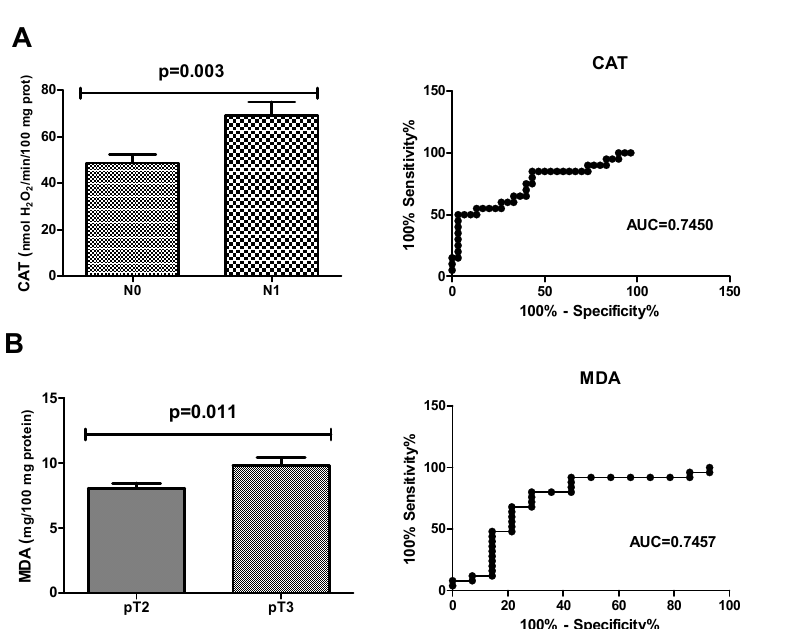
Figure 5. ( A ) ROC analysis of CAT in CRC patients with (N1 + N2) and without (N0) regional lymph node metastasis. ( B ) ROC analysis of MDA in CRC patients with the tumour grown into the muscularis propria (pT2) and with the tumour grown through the muscularis propria and into the subserosa (pT3). Abbreviations: AUC, area under curve; ROC, receiver operating characteristic.